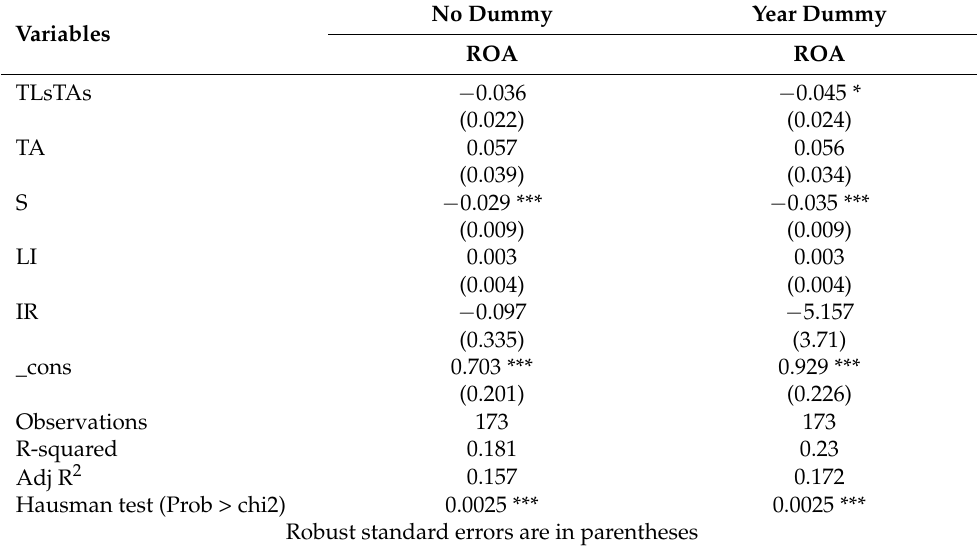
Table 18. Results of the Fixed Effects of TLsTAs on ROA, as per Panel Data Regression (Profit-Making